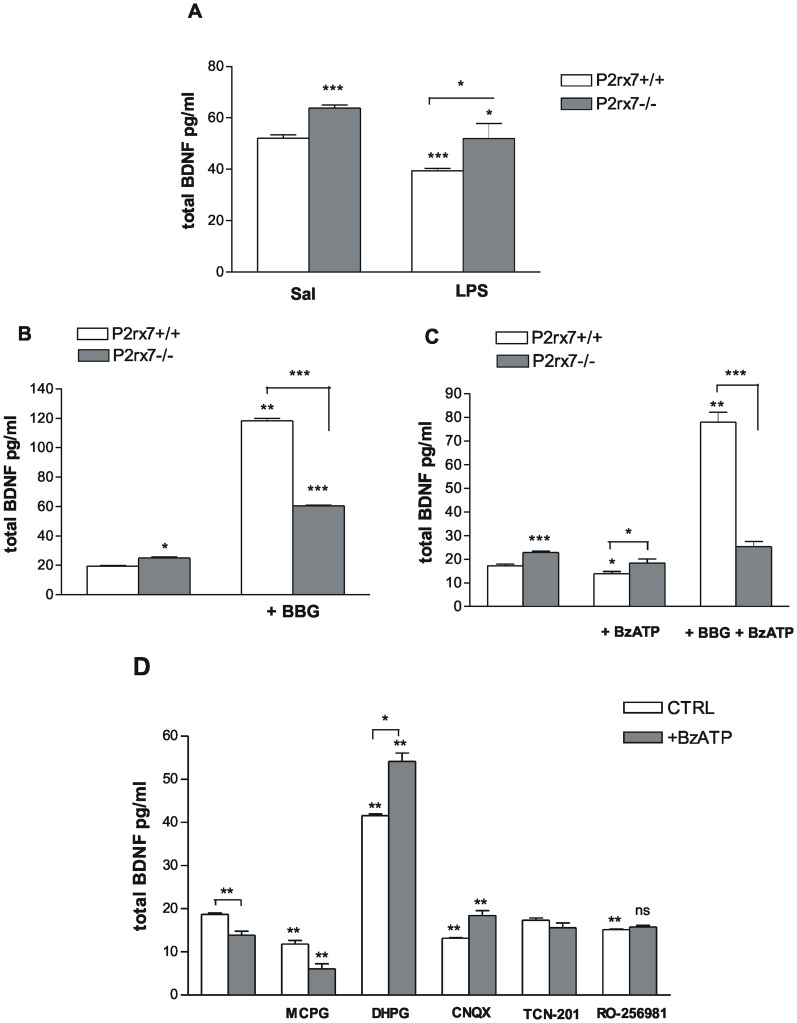
P2rx7 participates in the regulation of the basal BDNF expression in the mouse hippocampus.A/BDNF protein expression in the hippocampus of P2rx7+/+ and P2rx7−/− mice after saline (Sal) and LPS (1 mg/kg i.p.) treatment. Intraperitoneal injection of LPS significantly decreased the level of BDNF expression in the hippocampus of P2rx7+/+ mice at 24 h after treatment compared with saline treatment (Sal). The BDNF protein level was significantly higher in the hippocampus of saline treated P2rx7−/− mice. The animals were sacrificed at 24 h after the injection of LPS/saline. The data are given as the mean level of neurotrophin ± SEM. Asterisks indicate significant differences between the saline and LPS-treated groups and between the WT and P2rx7−/− groups (n = 4–6, *P<0.05, *** P<0.001). B, C Effect of the P2X7 receptor antagonist BBG (B) and the P2X agonist BzATP (C) on the basal level of BDNF in the hippocampus of P2rx7+/+ and P2rx7−/− mice. The P2rx7 antagonist Brilliant Blue G (BBG, 100 nM) was applied 15 min before the start of BzATP incubation, and BzATP (100 µM) was added for 30 min. Notably, in the experiments with BzATP (C), Mg2+ was omitted from the incubation solution (see Methods). The data are given as the mean level of neurotrophin ± SEM. Asterisks indicate significant differences calculated by one-way ANOVA followed by Dunnett’s test (multiple comparisons) and Student’s t-test (pairwise comparisons) (*P<0.05, **P<0.01,***P<0.001). D/Effect of glutamate receptor antagonists and agonist on the basal and BzATP-induced decrease in BDNF expression in hippocampal slices of P2rx7+/+ mice. The inhibitory effect of BzATP (100 µM) could be counteracted using CNQX (10 µM), the non-NMDA-type glutamate receptor antagonist, TCN-201 (10 µM), the NMDA-NR1/NR2A glutamate receptor antagonist and RO-256981 (3 µM) the NMDA-NR2B glutamate receptor antagonist but not using MCPG (200 µM), the group I mGluR antagonist. CNQX, TCN-201 and RO-256981 was added for 15 min, MCPG was applied for 30 min, and the group I mGluR agonist, DHPG (100 µM), was administered for 10 min. Data are given as the mean level of neurotrophin ± SEM with and without (first columns) the indicated antagonists in the presence (BzATP) or absence (CTRL) of BzATP. Asterisks indicate significant differences calculated using one-way ANOVA followed by Dunnett’s test and Student’s t-test (ns P>0.05, **P<0.01), as appropriate, indicated by the horizontal bars.